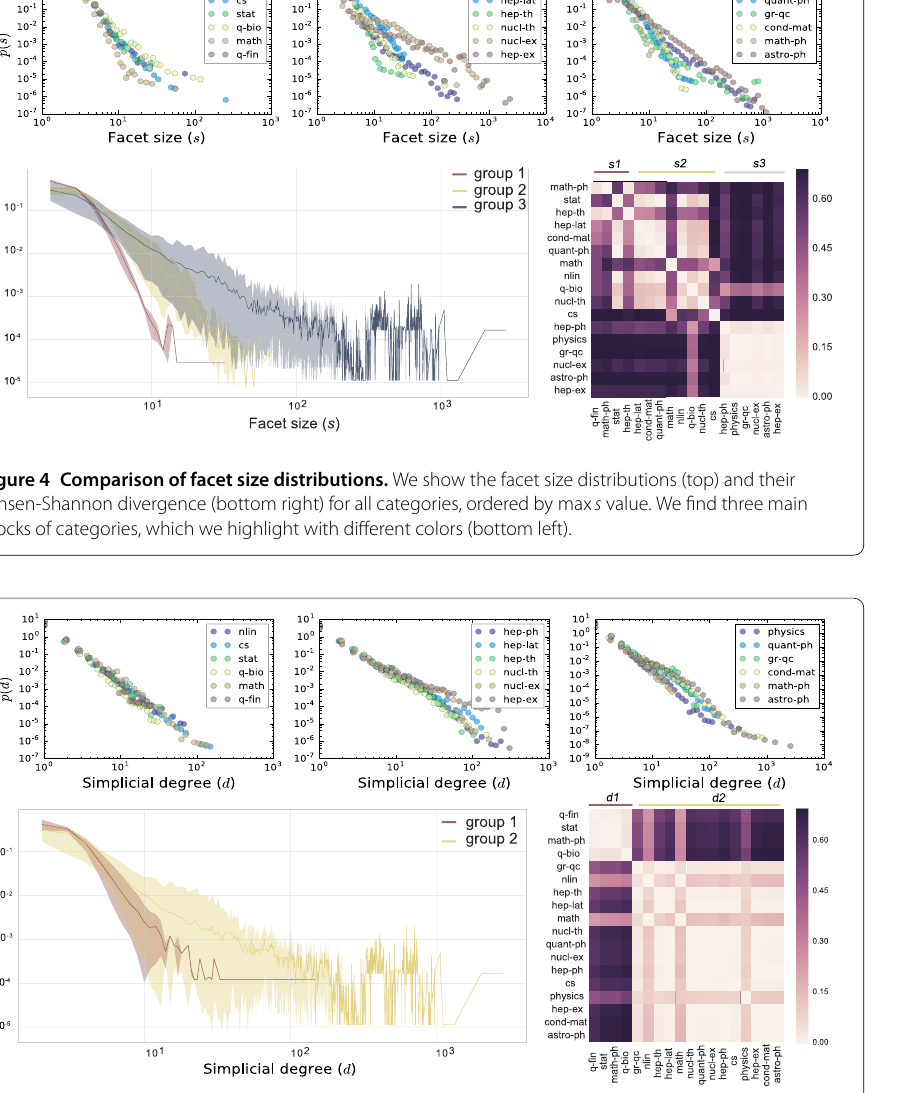
Figure 5 Comparison of simplicial degree distributions. We show the simplicial degree distributions (top) and their Jensen-Shannon divergence (bottom right) for all categories, ordered by max d value. As opposed to the facet distributions, we find two main groups of categories, which we highlight with different colors (bottom